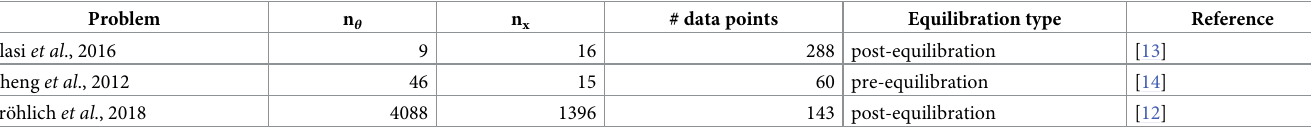
Table 1. Overview of the models and optimization problems considered in this study.